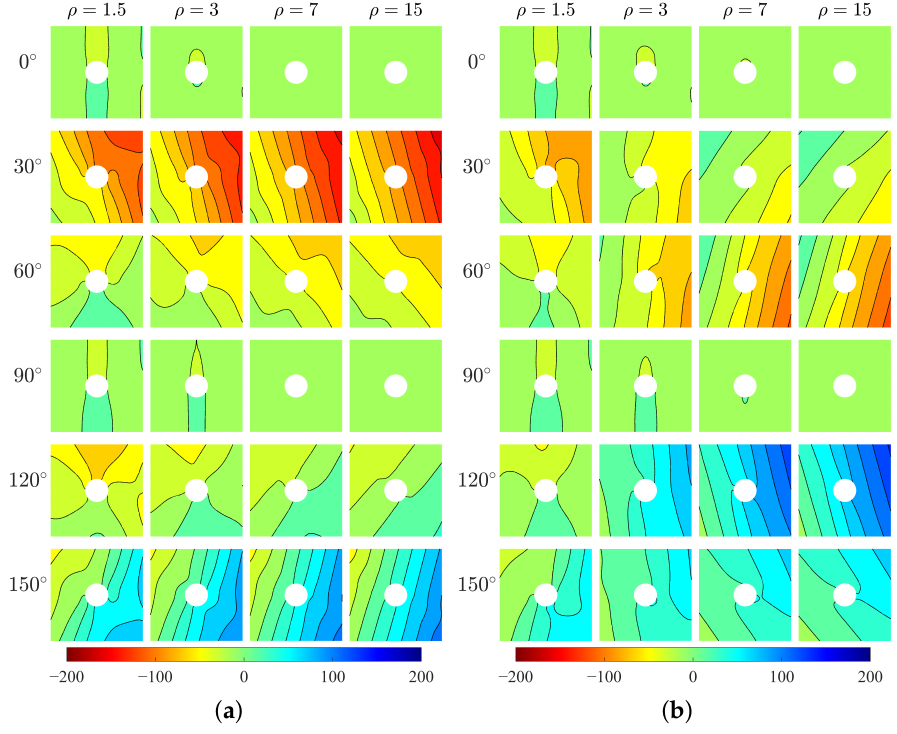
Figure 4. Vertical displacement u 2 , mm, ( a ) Cosserat, ( b )